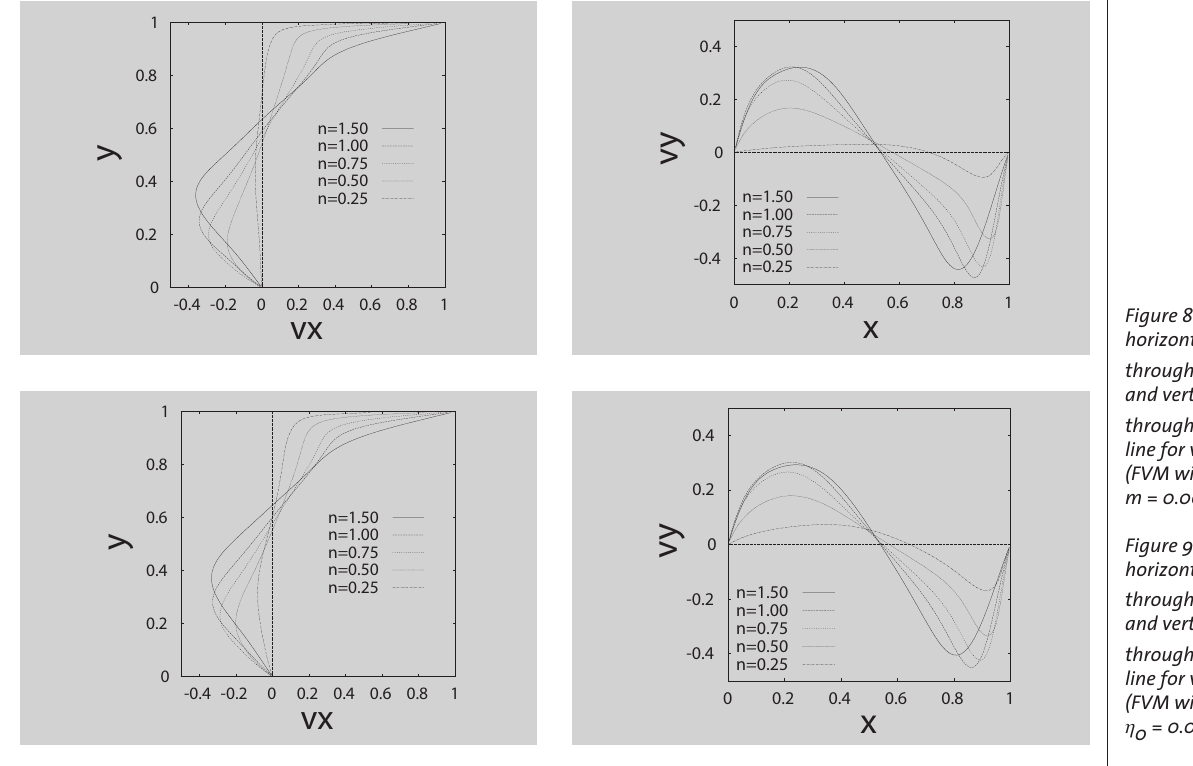
Figure 8: The profile of horizontal velocity vx through vertical centerline and vertical velocity vy through horizontal center- line for various n values (FVM with Power Law using m = 0.0025). Figure 9: The profile of horizontal velocity vx through vertical centerline and vertical velocity vy through horizontal center- line for various n values (FVM with Carreau model: h 0 = 0.0025, h ∞ = 0, l =